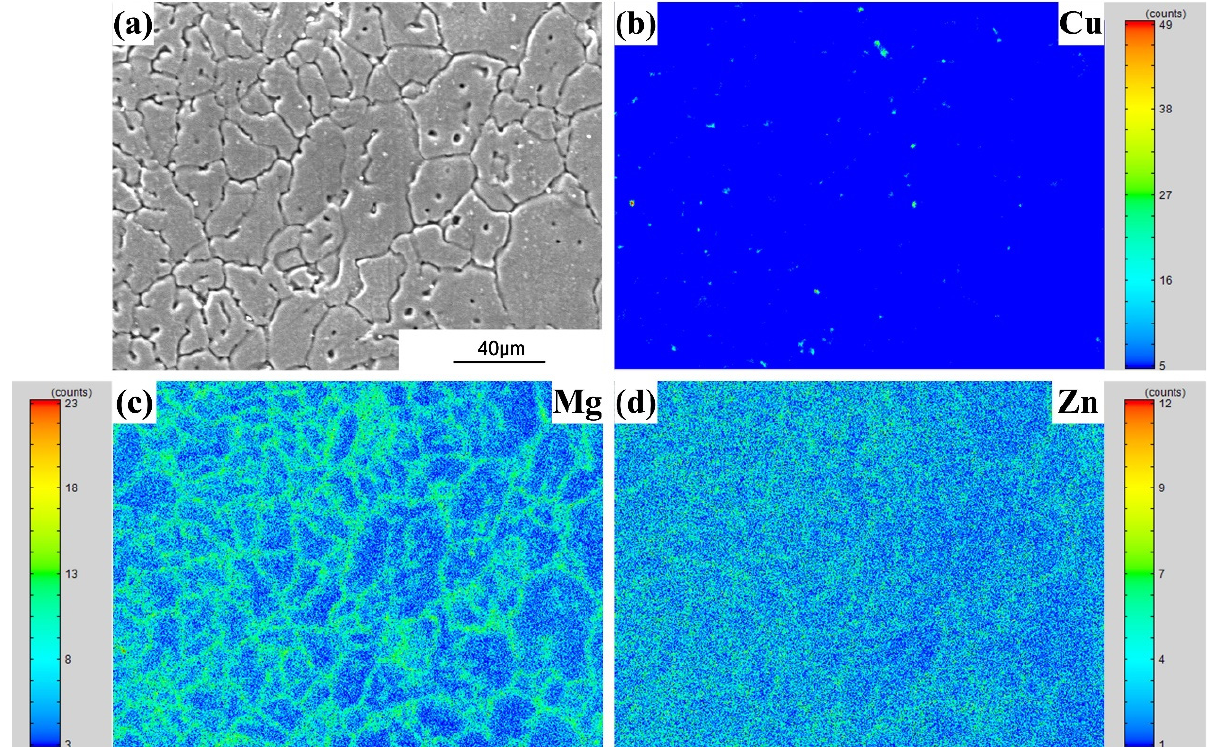
Figure 10. The EPMA mapping results (the AA7075/Al-Cu 4.5 -Si 1.5 weld): ( a ) Secondary electronic image; ( b ) Cu distribution; ( c ) Mg distribution; ( d ) Si distribution.